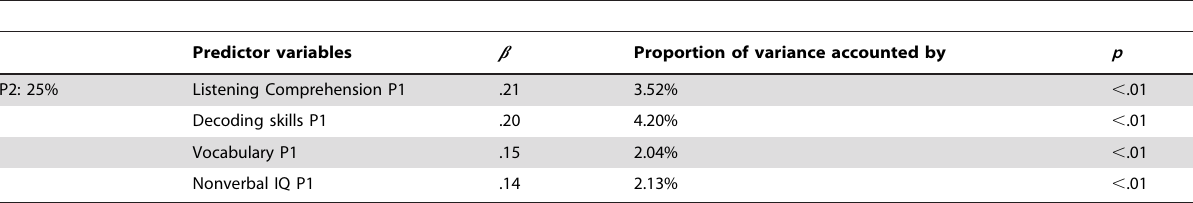
Table 5. Standard multiple regression analyses with the reading comprehension of a story as dependent variable and variables of interest in P1 as predictors (for decoding skills: accuracy scores for word and pseudoword reading).